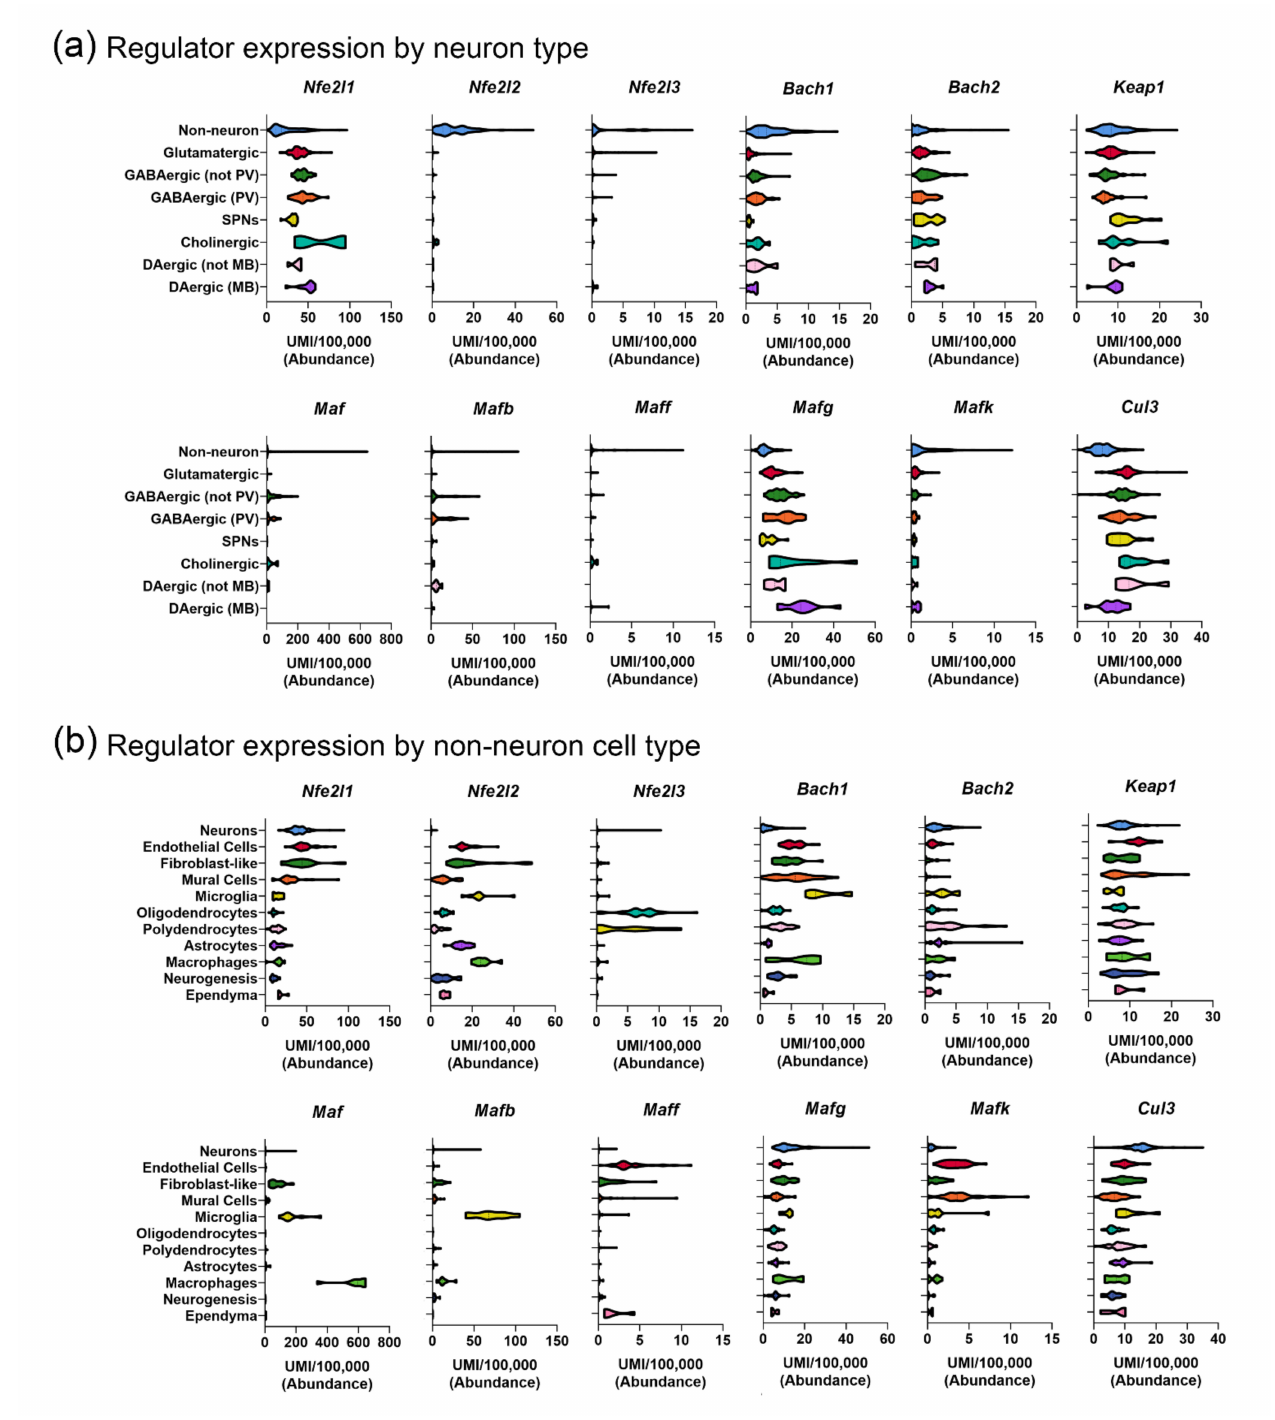
Figure 2. Transcript abundance for transcriptional regulators was assessed in neuronal ( a ) and non-neuronal ( b ) populations using the Dropviz.org dataset [4]. All values are expressed as UMI (unique molecular identifier)/100,000 in each cell subcluster. Statistically significant differences among groups for ( a , b ) are included in Supplementary Table